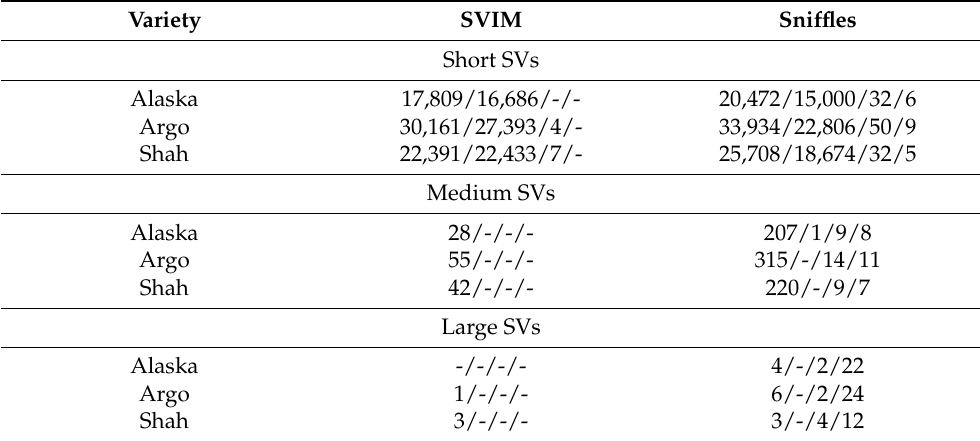
Table 3. Numbers of structural variants in the genomes of Alaska, Argo, and Shah varieties. Dele- tions/insertions/duplications/inversions.